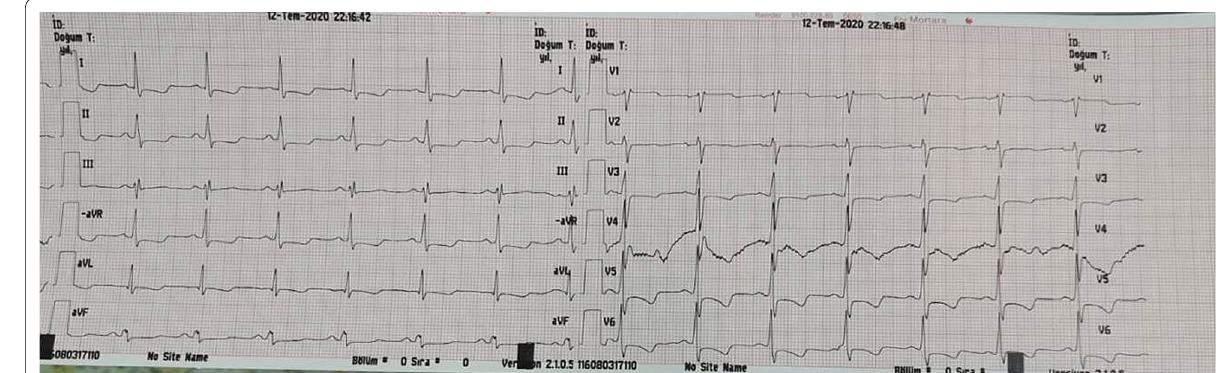
Fig. 1 The first preoperative electrocardiography